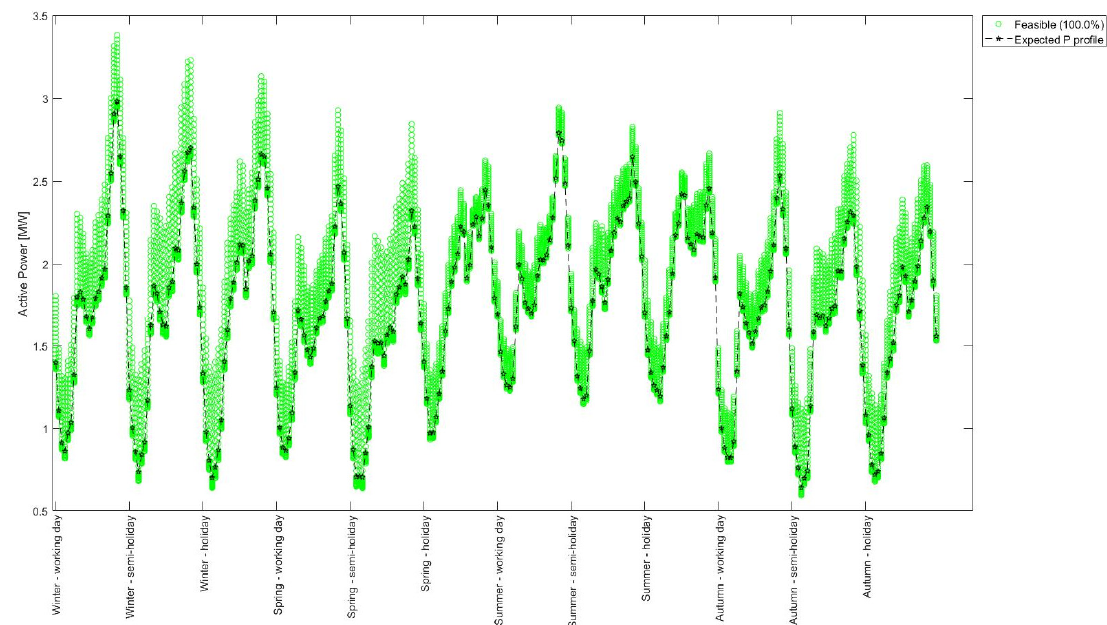
Figure 5. Potential P profile during all representative days, feeder R2—case A (“only DG”).